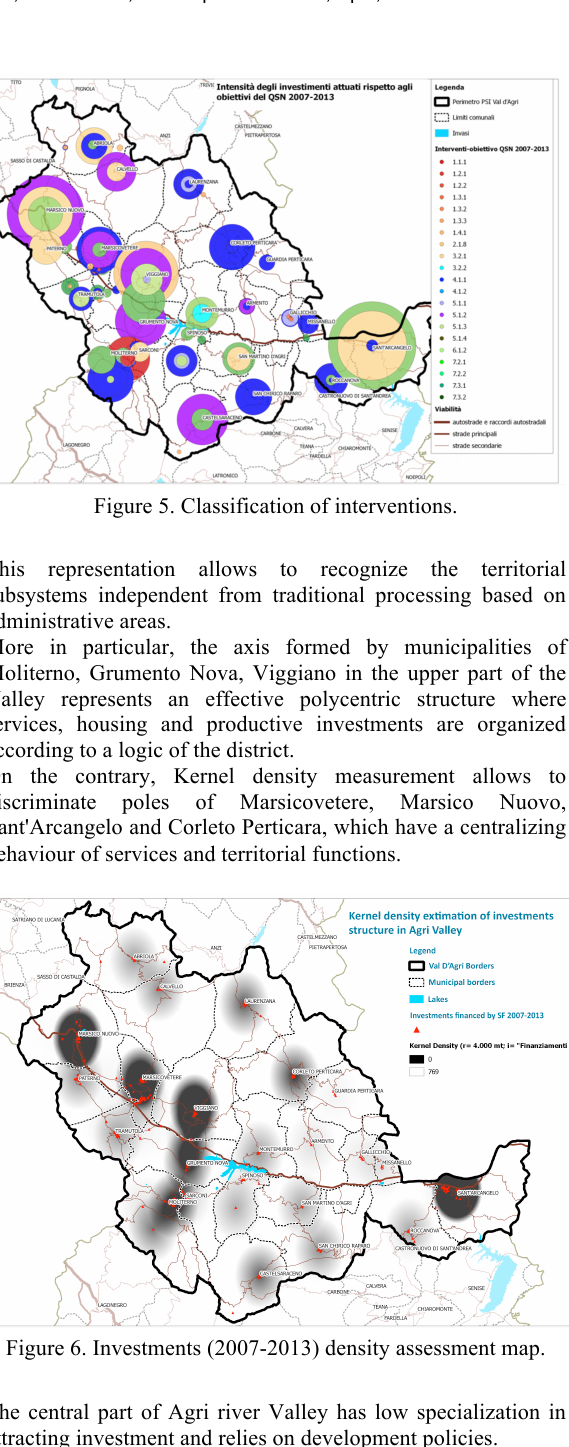
Figure 4. Intensity of public financing.